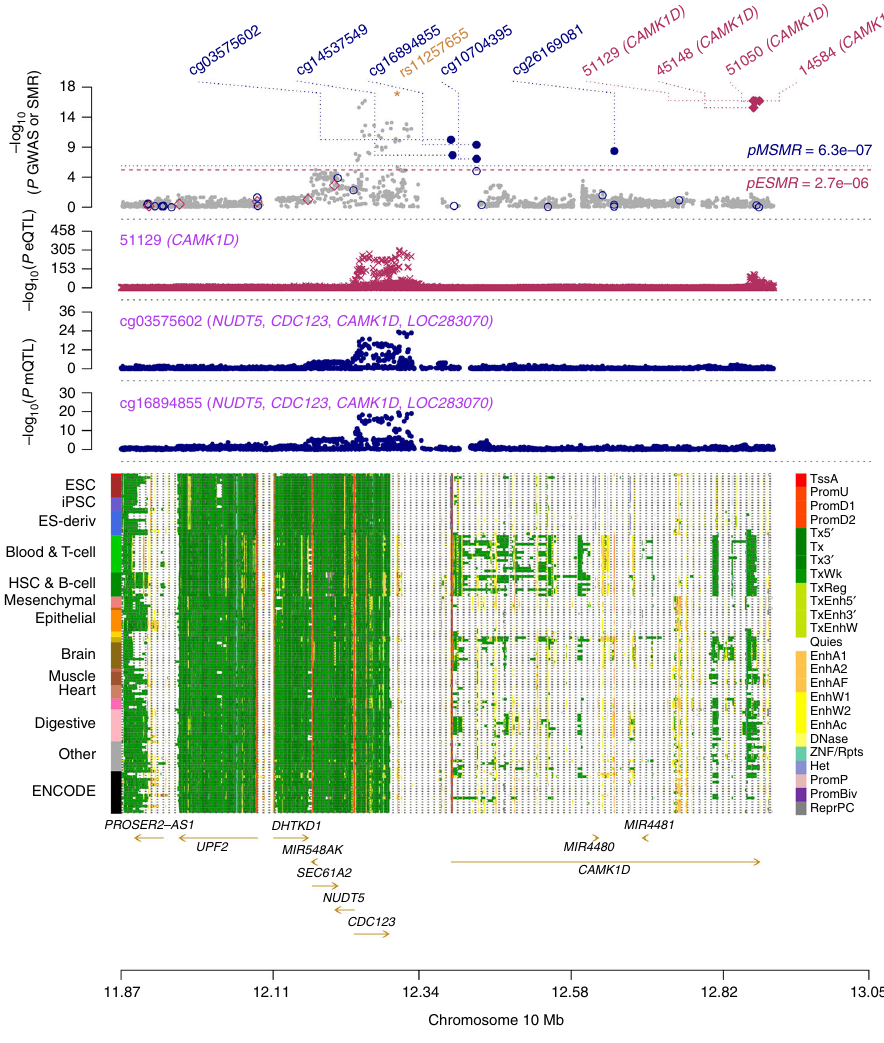
Fig. 2 Prioritizing genes and regulatory elements at the CAMK1D locus for T2D. The results of the SMR analysis that integrates data from GWAS, eQTL, and mQTL studies are shown. The top plot shows − log 10 ( P value) of SNPs from the GWAS meta-analysis for T2D. Red diamonds and blue circles represent − log P value) from the SMR tests for associations of gene expression and DNAm probes with T2D, respectively. Solid diamonds and circles represent the 10 ( probes not rejected by the HEIDI test. The yellow star denotes the top cis-eQTL SNP rs11257655. The second plot shows − log 10 ( P value) of the SNP association for gene expression probe 51129 (tagging CAMK1D ). The third plot shows − log 10 ( P value) of the SNP association with DNAm probes cg03575602 and cg16894855 from the mQTL study. The bottom plot shows 25 chromatin state annotations (indicated by colors) of 127 samples from Roadmap Epigenomics Mapping Consortium (REMC) for different primary cells and tissue types